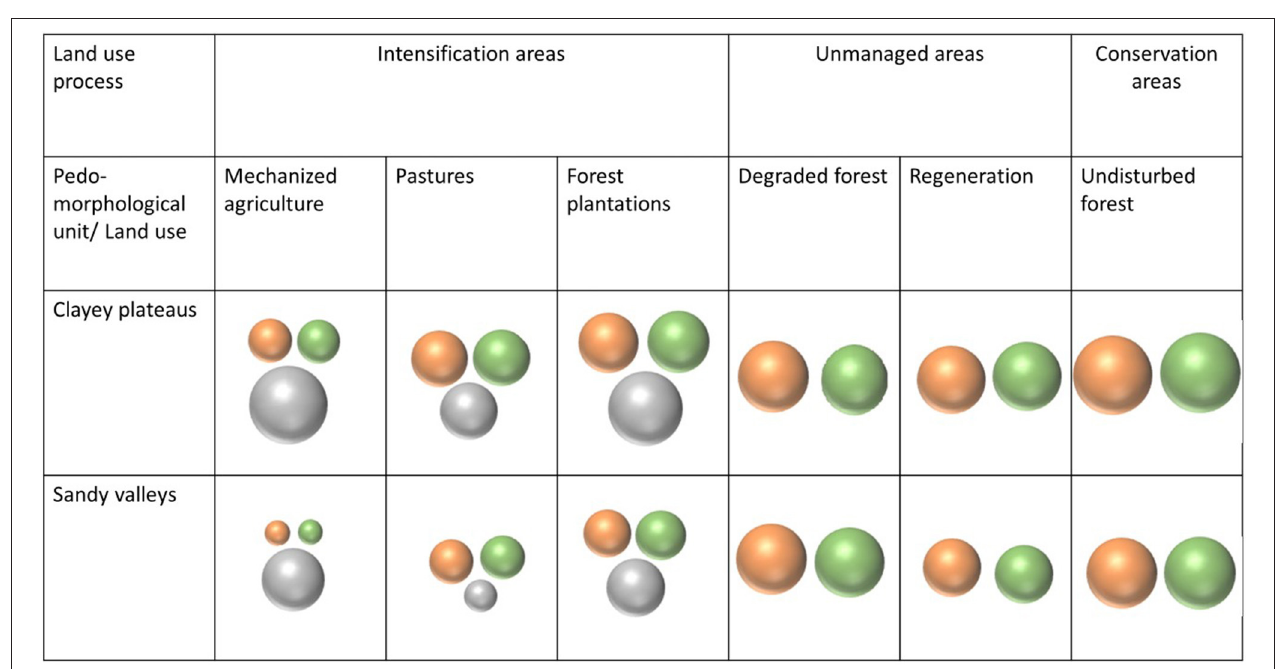
FIGURE 2 | Diagram of methodological steps followed to map the supply and demand of ecosystem services in Paragominas.